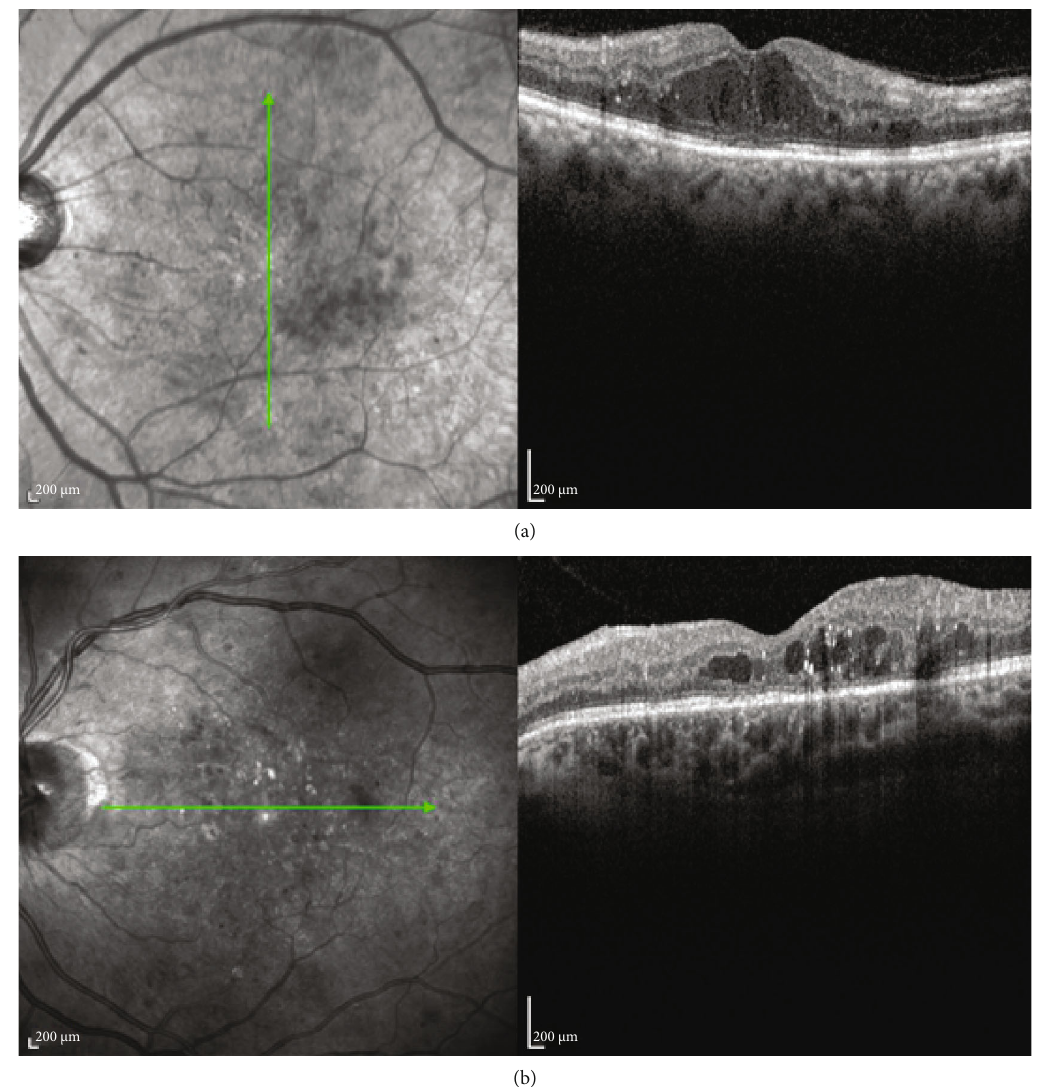
Figure 1: (A) Optical coherence tomography of a female patient with diabetic macular edema and elevated lipoprotein (a), as well as decreased hematocrit and red blood count, which was associated with the disruption of the ellipsoid zone and an increase in central sub fi eld thickness. (B) Optical coherence tomography of a male patient with diabetic macular edema and elevated white blood cells, which were associated with the presence of hyperre fl ective